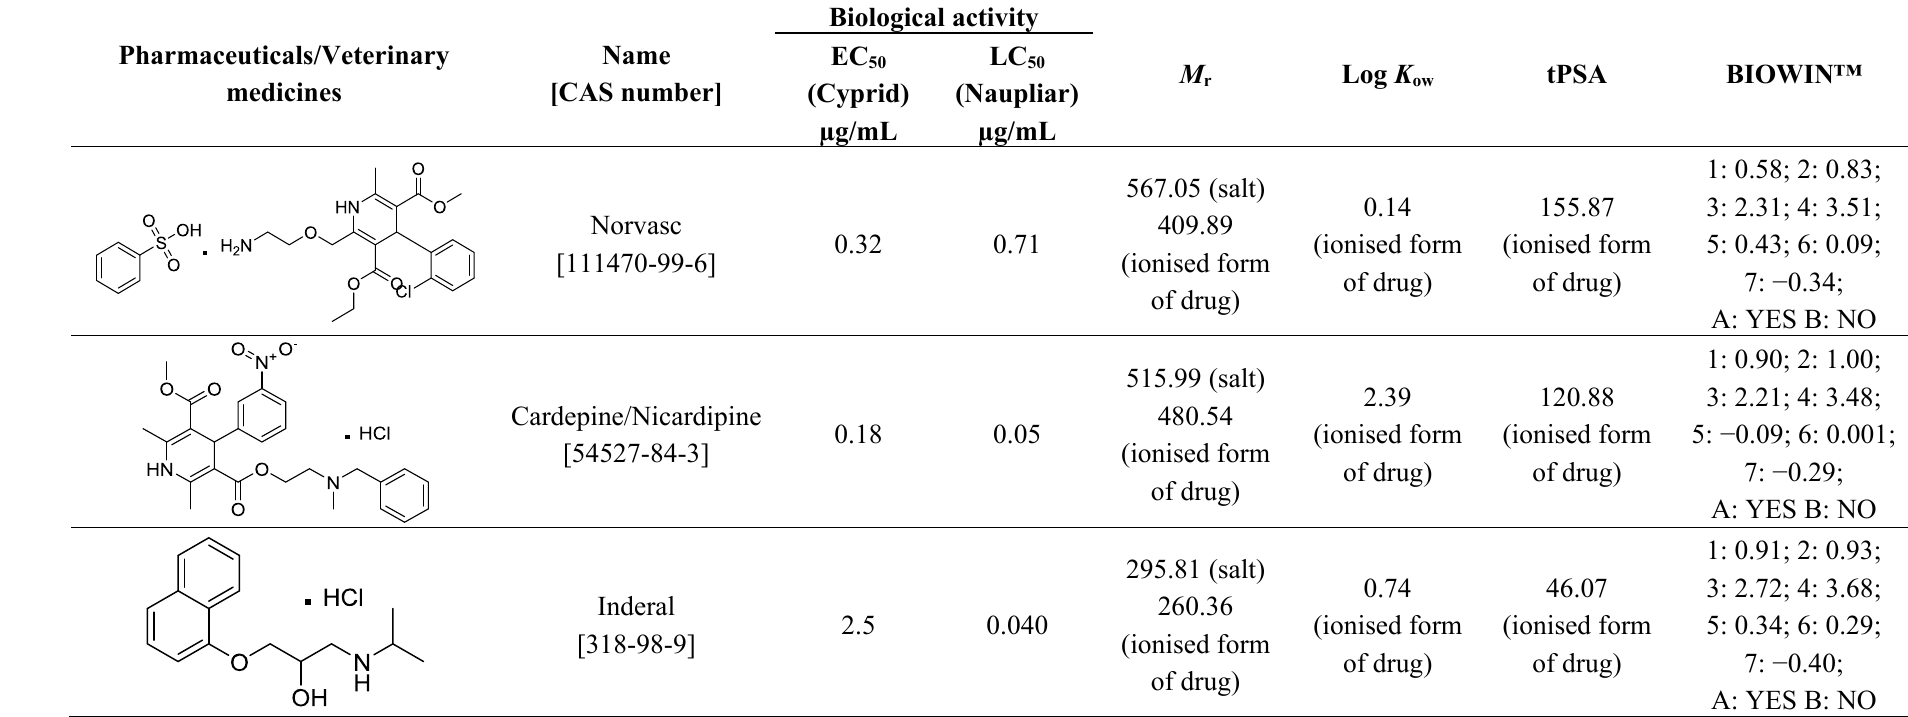
Table 4. Pharmaceuticals and veterinary medicines possessing anti-fouling properties. EC = effective concentration at which 50% of larval 50 settlement was prevented; LC = concentration lethal to 50% of nauplii; M = molecular weight; tPSA = total polar surface area calculated; 50 r of the ionised or neutral form of pharmaceuticals (as indicated) were calculated. Log K = log of water/octanol partition coefficient. Log K ow ow BIOWIN™ models: 1-linear, 2-non-linear, 3-ultimate, 4-primary, 5-linear MITI, 6-non-linear MITI, 7-anaerobic; Criteria A-model 2 or 6 > 0.5 and model 3 > 2.2; Criteria B-model 3 “weeks” or faster and model 5 > 0.5. Biological data for Phentolamine, Prazosin, Medetomidine and Clonidine were obtained from [29]. Biological data for all other compounds were obtained from